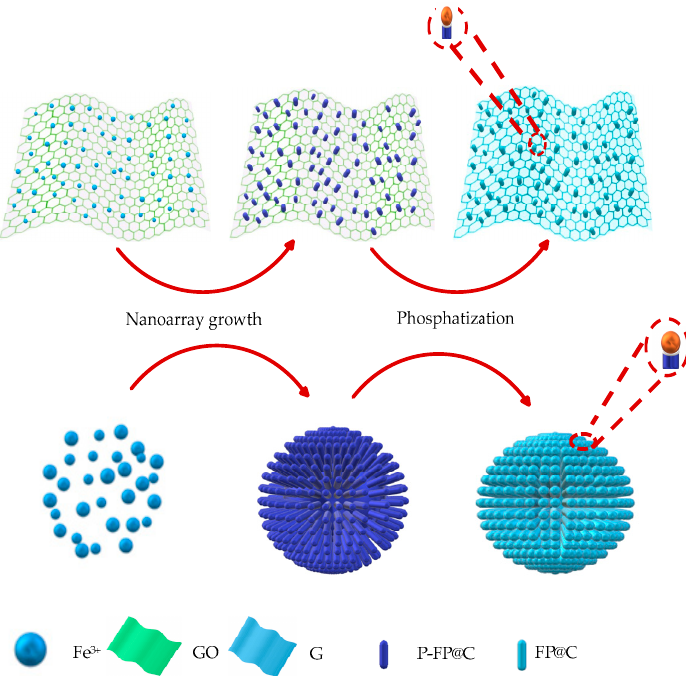
Figure 4. Schematic illustration of formation process of G ⊥ FP@C-NA.